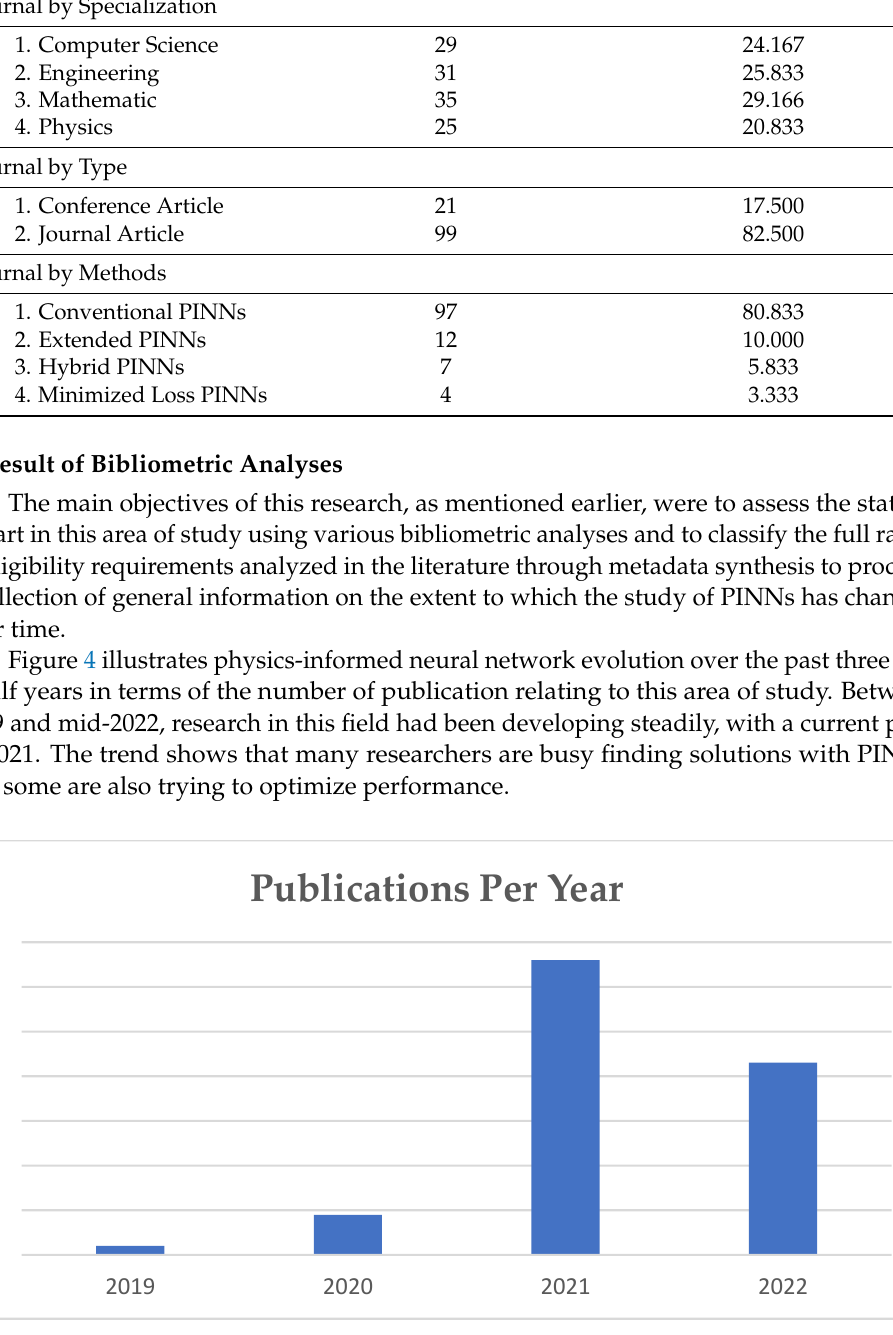
Table 1. Quantitative study characteristics.